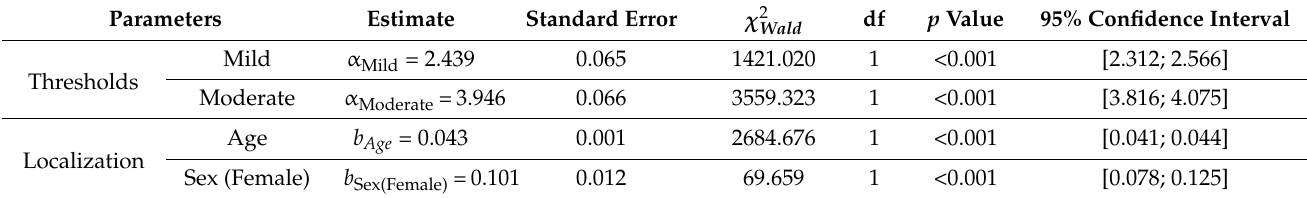
Table 2. Estimates and significance of the adjusted “Probit”